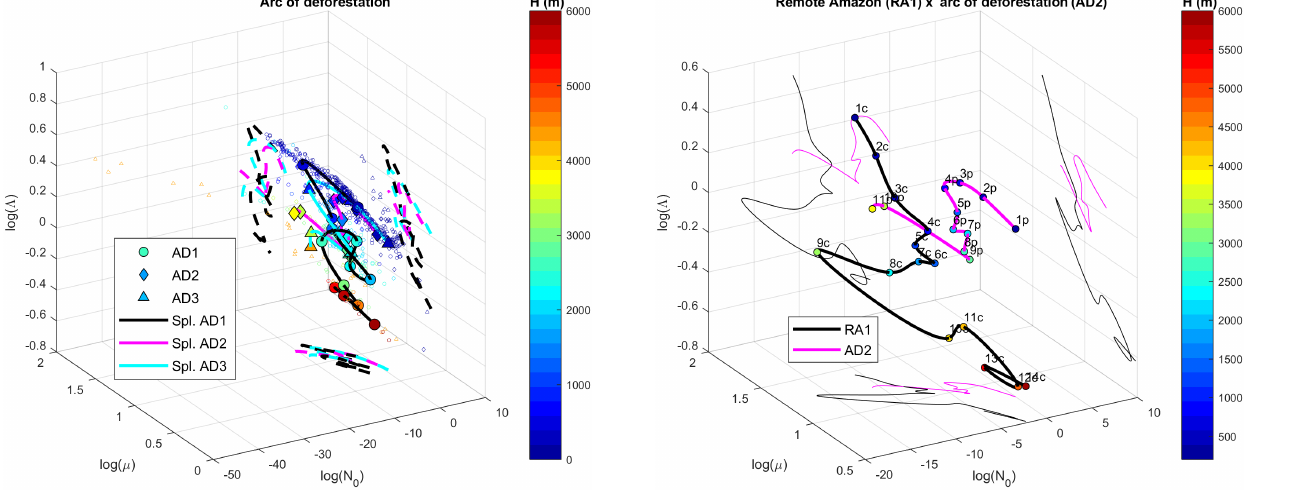
Figure 7. Similar to Fig. 5, but for flights AD1, AD2, and AD3 over the arc of deforestation.